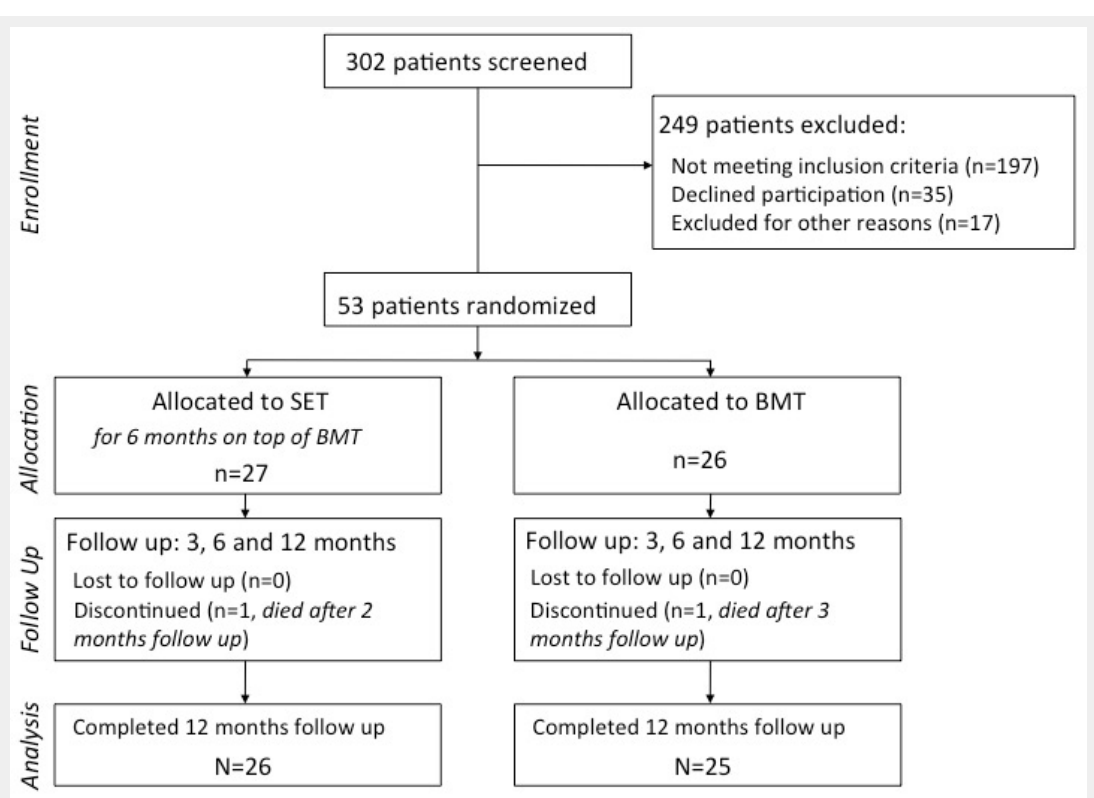
CONSORT flow diagram. * Reasons for exclusion: 15 patients were enrolled in another clinical trial and two patients deteriorated prior to randomization and underwent